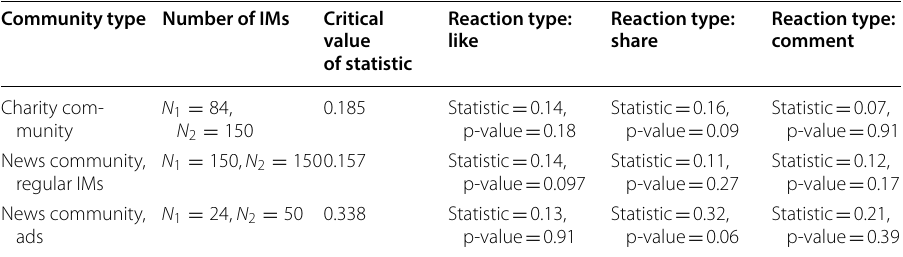
Table 4 Error metrics for the two types of thematic communities (statistic is the value of the statistics of the Kolmogorov–Smirnov criterion for two samples, critical value of statistic denoted maximum statistic value to determine that the samples have the same distribution)